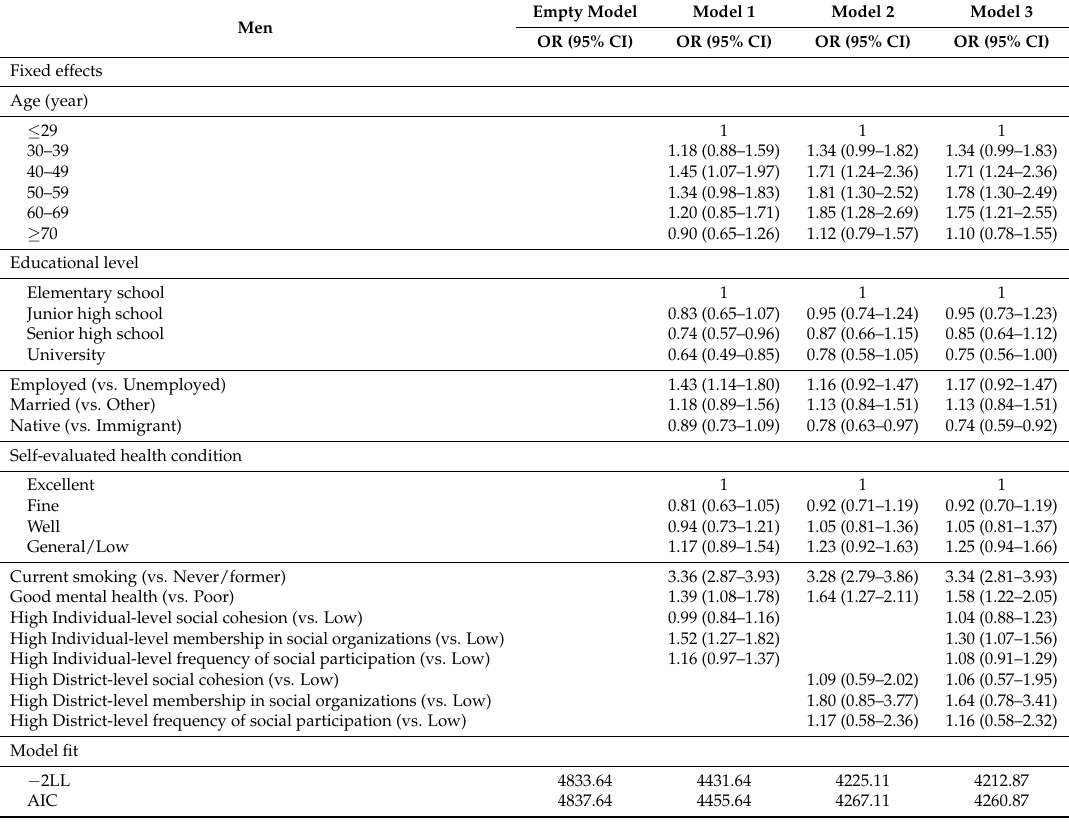
Table 2. The odds ratios and 95% confidence intervals for HD associated with individual and district-level social capital among men.